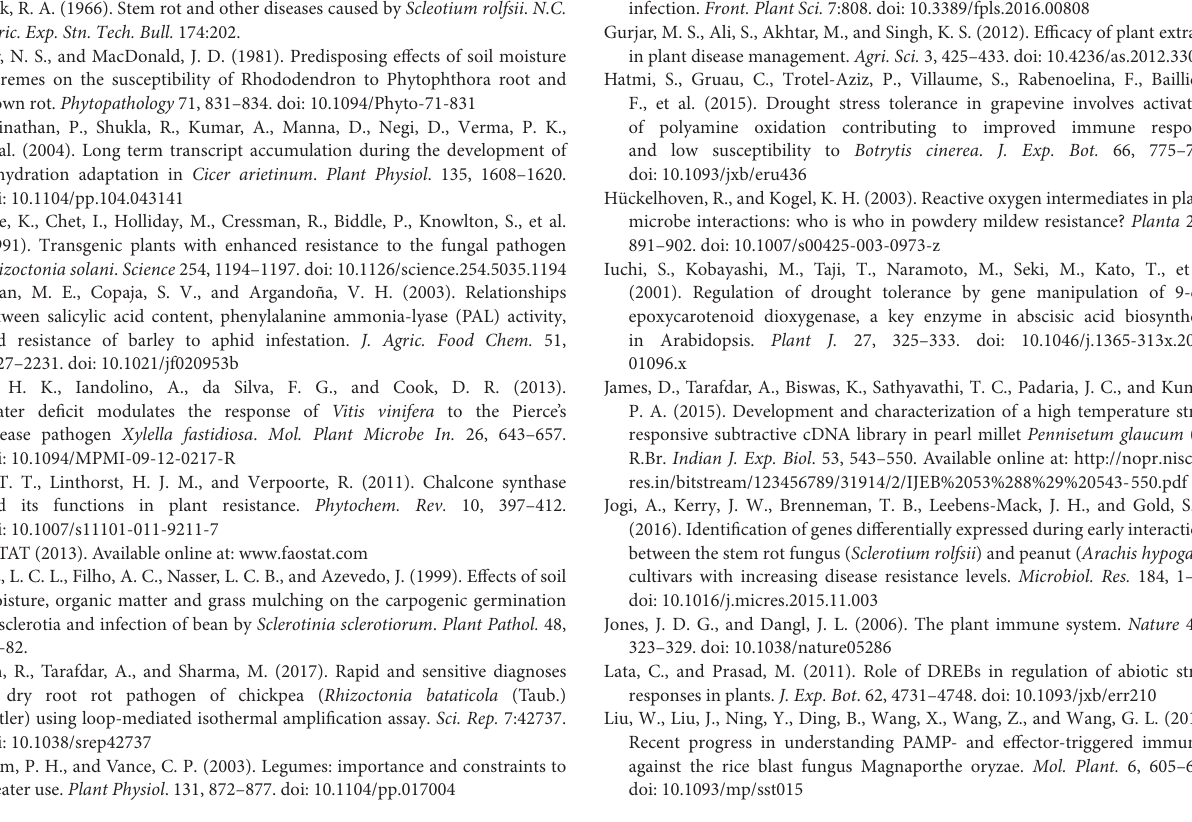
Figure S1 | Calibration of qPCR for quantification of S. rolfsii Standard curve showing the correlation between the log10 DNA quantity (ng) vs. the Ct values for 10-fold dilution of S rolfsii pure genomic DNA. The single peak of targeted amplicon at melting temperature (Tm) 81.5 ◦ C indicates the specificity of the qPCR primers to S. rolfsii . No contaminating product was detected in PCR reaction. Figure S2 | Schematic diagram of molecular interaction between chickpea and S. rolfsii under low soil moisture condition. (Courtesy of diagram of plant cell wall: www.thoughtco.com/cell-wall-373613).